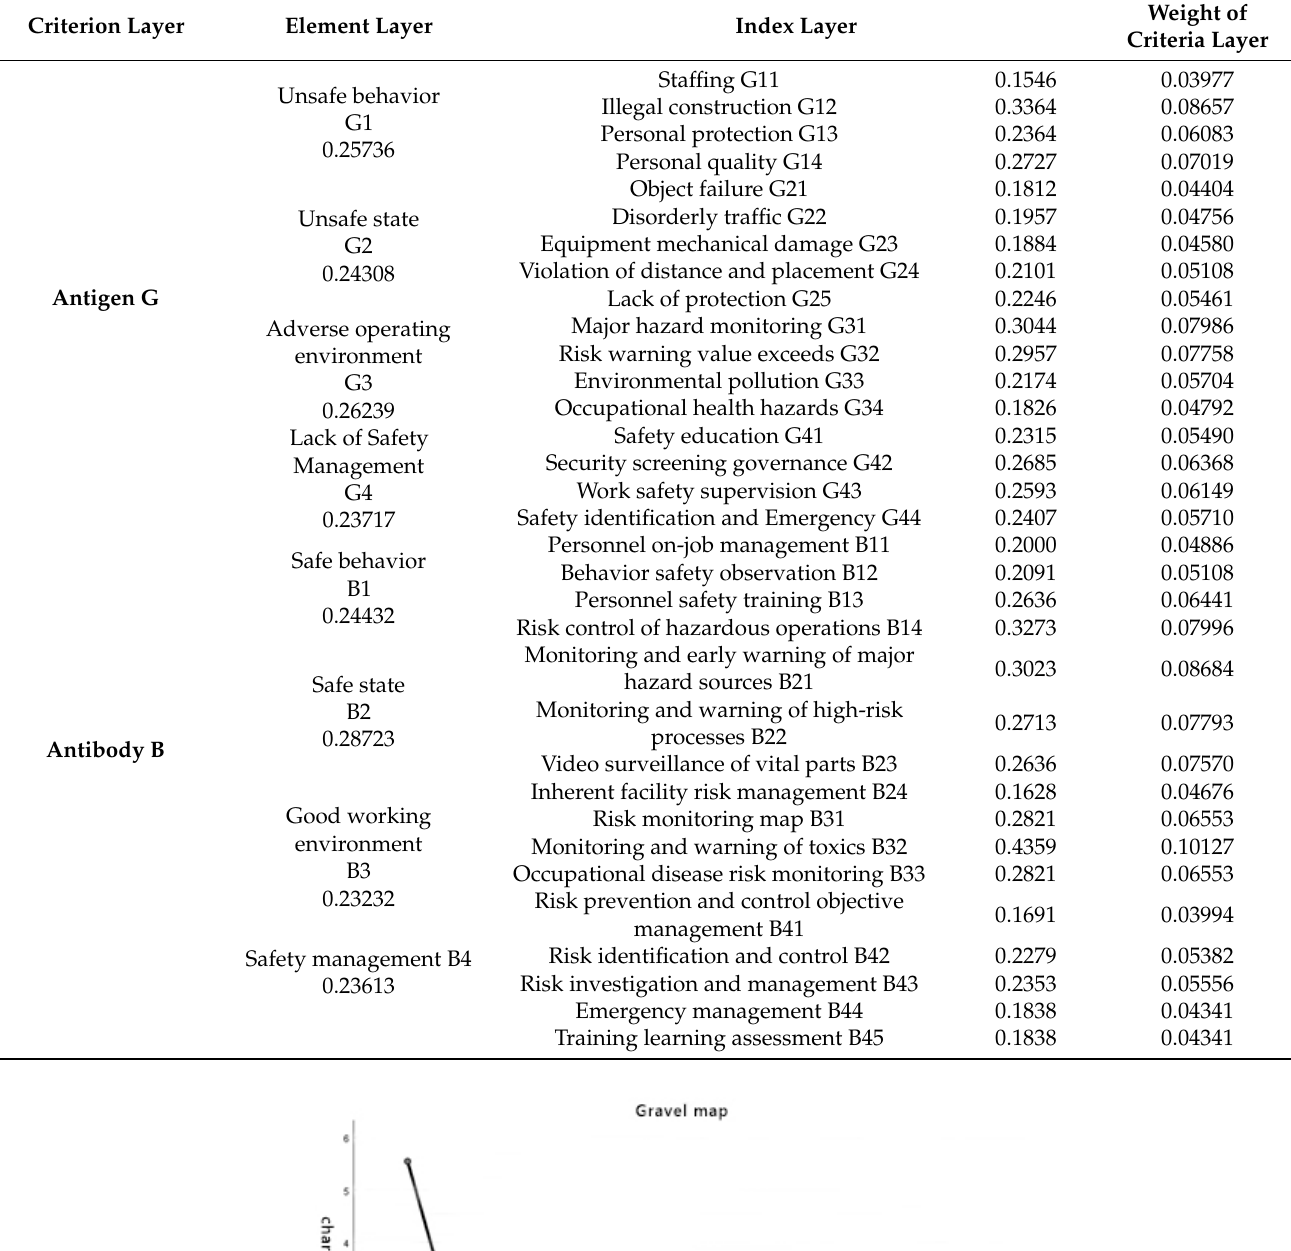
Table 7. Safety production index system of chemical enterprises based on immune model.